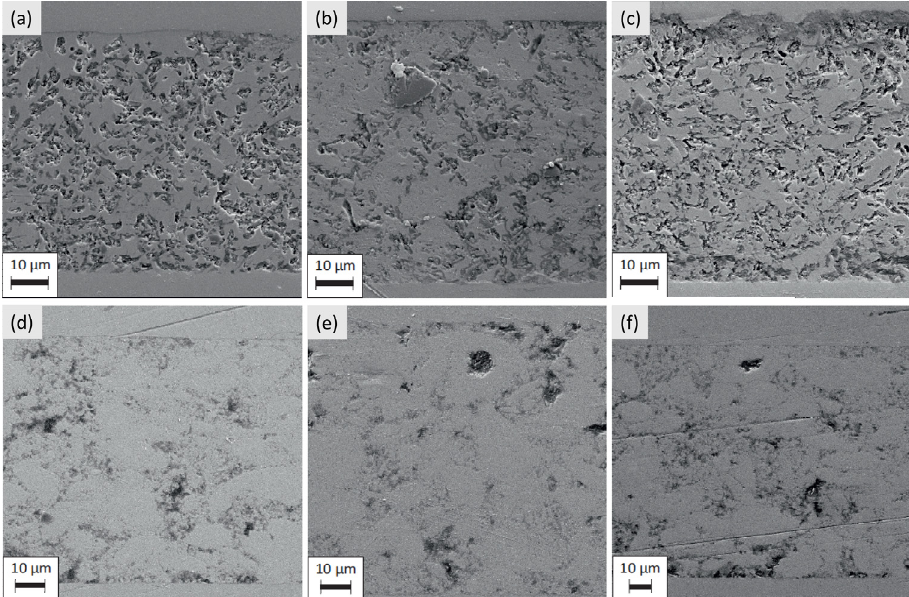
Figure 8. Results of SEM observations of the pure glass and 40 wt.% YSZ composite samples that underwent repeated thermal cycles: ( a ) glass after 3 cycles, ( b ) glass after 5 cycles, ( c ) glass after 10 cycles, ( d ) composite after 3 cycles, ( e ) composite after 5 cycles, ( f ) and composite after 10 cycles.